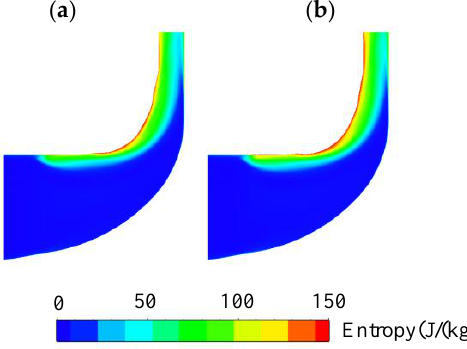
Figure 9. Entropy distribution of meridional averaged plane (( a ): plain, ( b ): plateau).